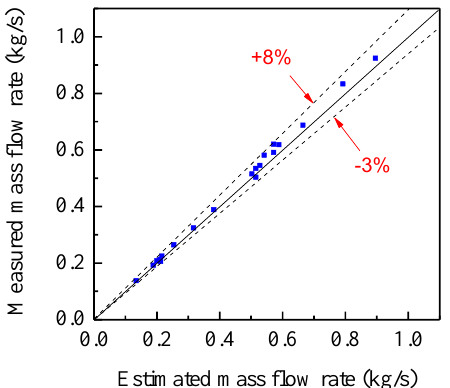
Figure 17. Comparison of the measured mass flow ratewith the estimated value for the sensor configuration in Figure 2.